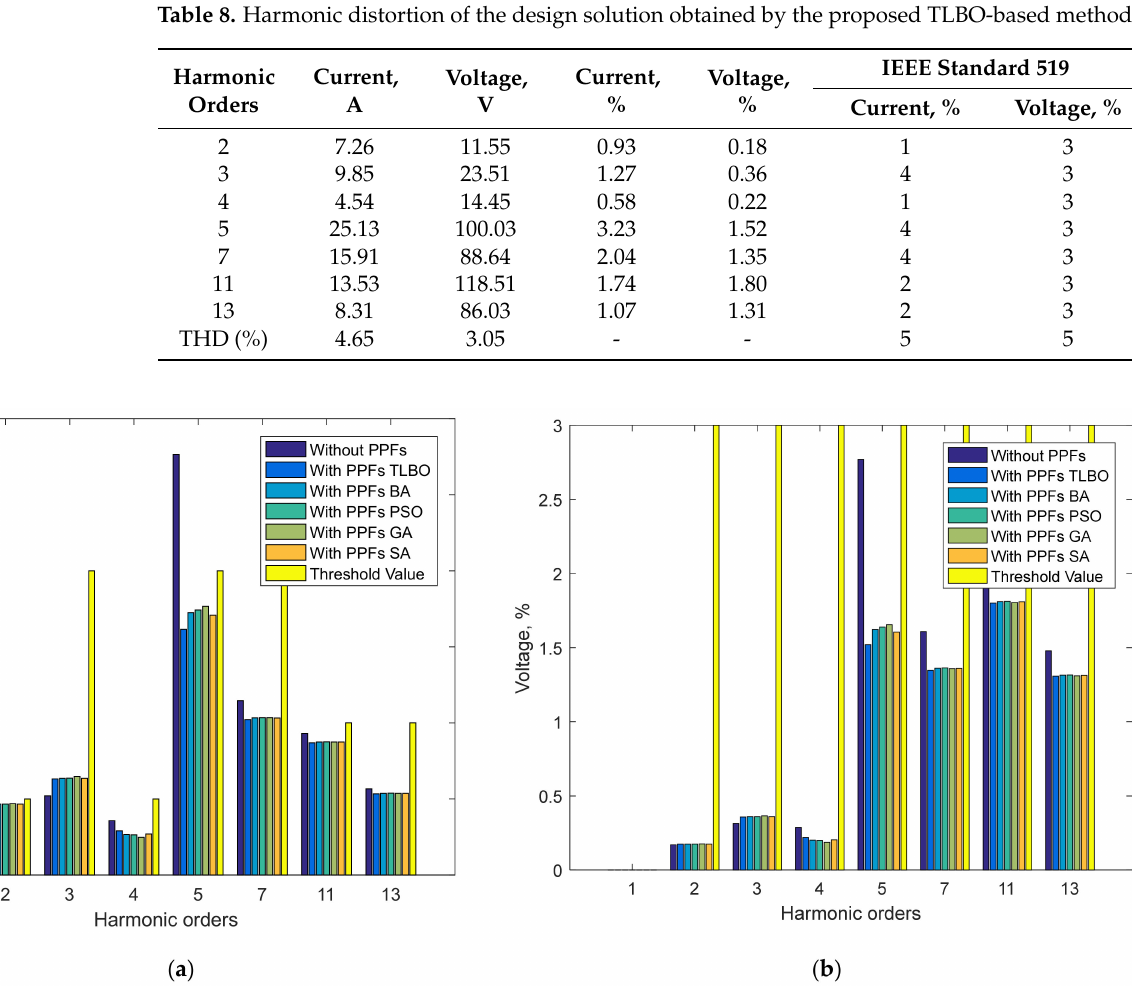
Figure 7. Individual harmonic distortions before and after compensation ( a ) current and ( b )